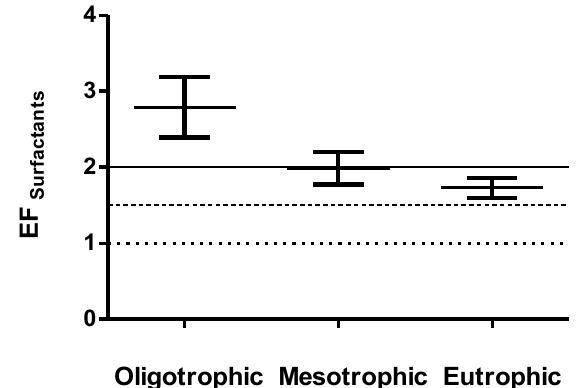
Fig. 3. Scatter plot of surfactant enrichment factor (EF) against observed wind speeds. Dashed line represent EF =